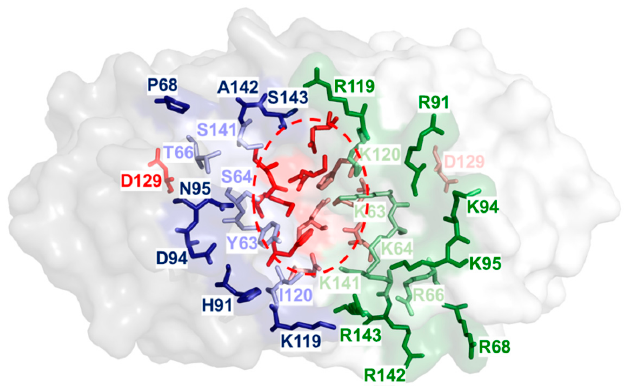
Figure A1. Homology model of NSN from Pseudomonas syringae in top view. Amino acid residues of the conserved HxK(x) 4 D(x) 6 GSxN motif are given as sticks in dark and light red in the respective monomer. Numbering of amino acids that are part of the catalytic site was omitted for clarity (encircled in red, dashed line), except for amino acid residue D129, which is part of the HxK(x) 4 D(x) 6 GSxN motif, but not part of the catalytic site. Naturally occurring amino acids of the outer and inner rings are also given as sticks and highlighted in dark and light blue, while substituted positively charged amino acid residues are indicated in dark and light green.